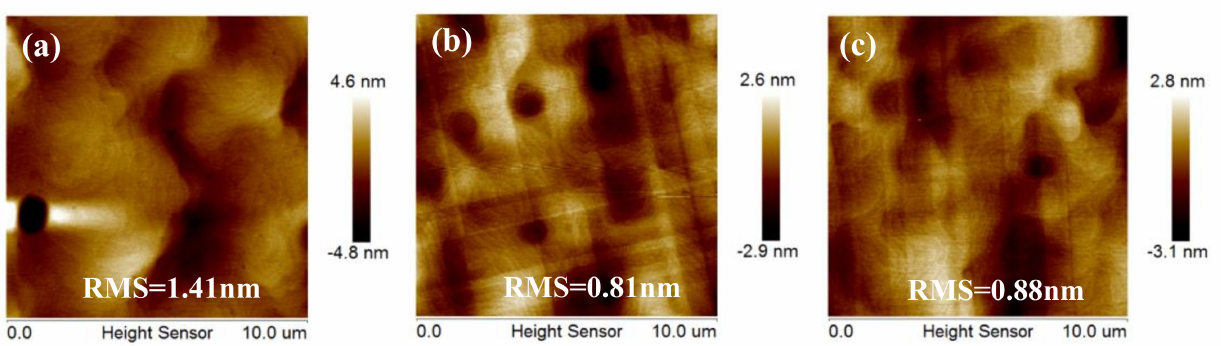
10 µ m 2 of 1.4 µ m thick Ge samples ( a ) without annealing ( b ) one-step annealing, and ( c ) two Figure 12. AFM images 10 × step annealing. RMS values of the Ge surface are ( a ) 1.41 nm, ( b ) 0.81 nm, and ( c ) 0.88 nm, respectively.